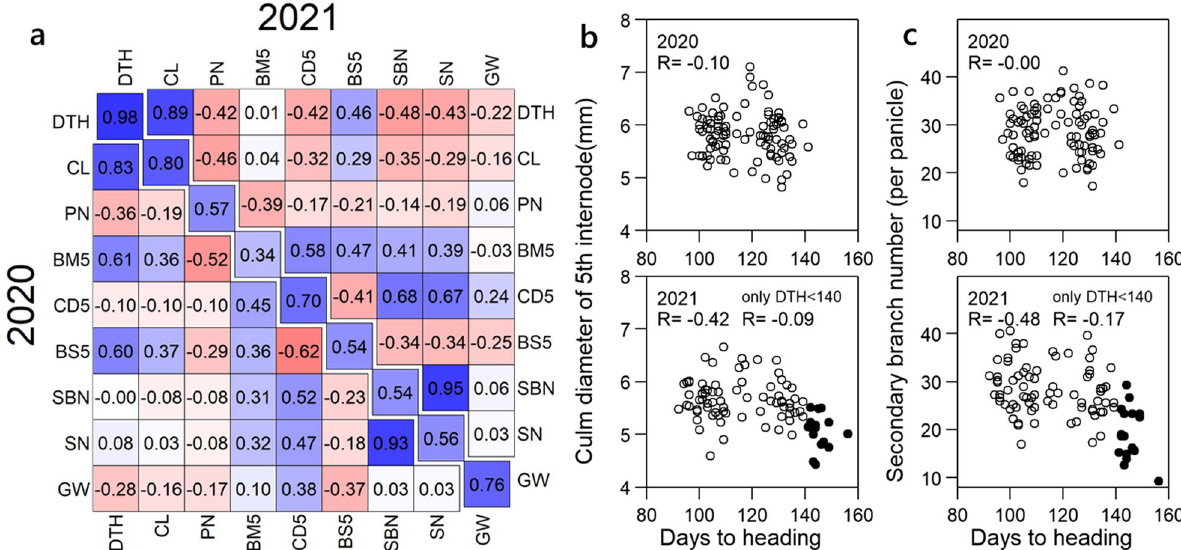
Fig. 2 Correlation among the traits in RILs. a Correlation matrix among extracted traits in RILs. The lower and upper triangular matrix shows the correlation coefficient in 2020 and 2021, respectively. Numbers on the diagonal indicate correlation coefficients between two years. A figure with all traits is shown in Additional file 1: Fig. S3. b , c Correlation between DTH and CD5 ( b ), and between DTH and SBN ( c ). Top: 2020, bottom: 2021. Black plots indicate lines which omitted from QTL analysis (lines whose DTH were over 140). Abbreviations: DTH: Days to heading, CL: Culm length, PN: Number of panicles, BM5: Bending moment at breaking of 5th internode, CD5: Culm diameter of 5th internode, BS5: Bending stress of 5th internode, SBN: Number of secondary branches, SN: Number of spikelets per panicle, GW: Grain